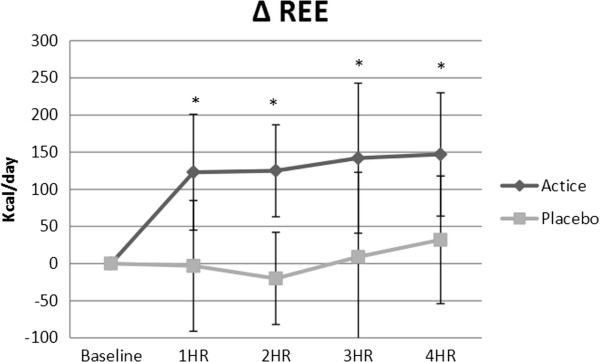
Resting energy expenditure changes. REE increased across all time points for DBX (active) ranging from a 123.4 to 147.3 kcal/day increase above baseline values. Changes were statistically different between groups at all time points post-supplementation. * indicates statistically significant changes (p ≤ 0.05).